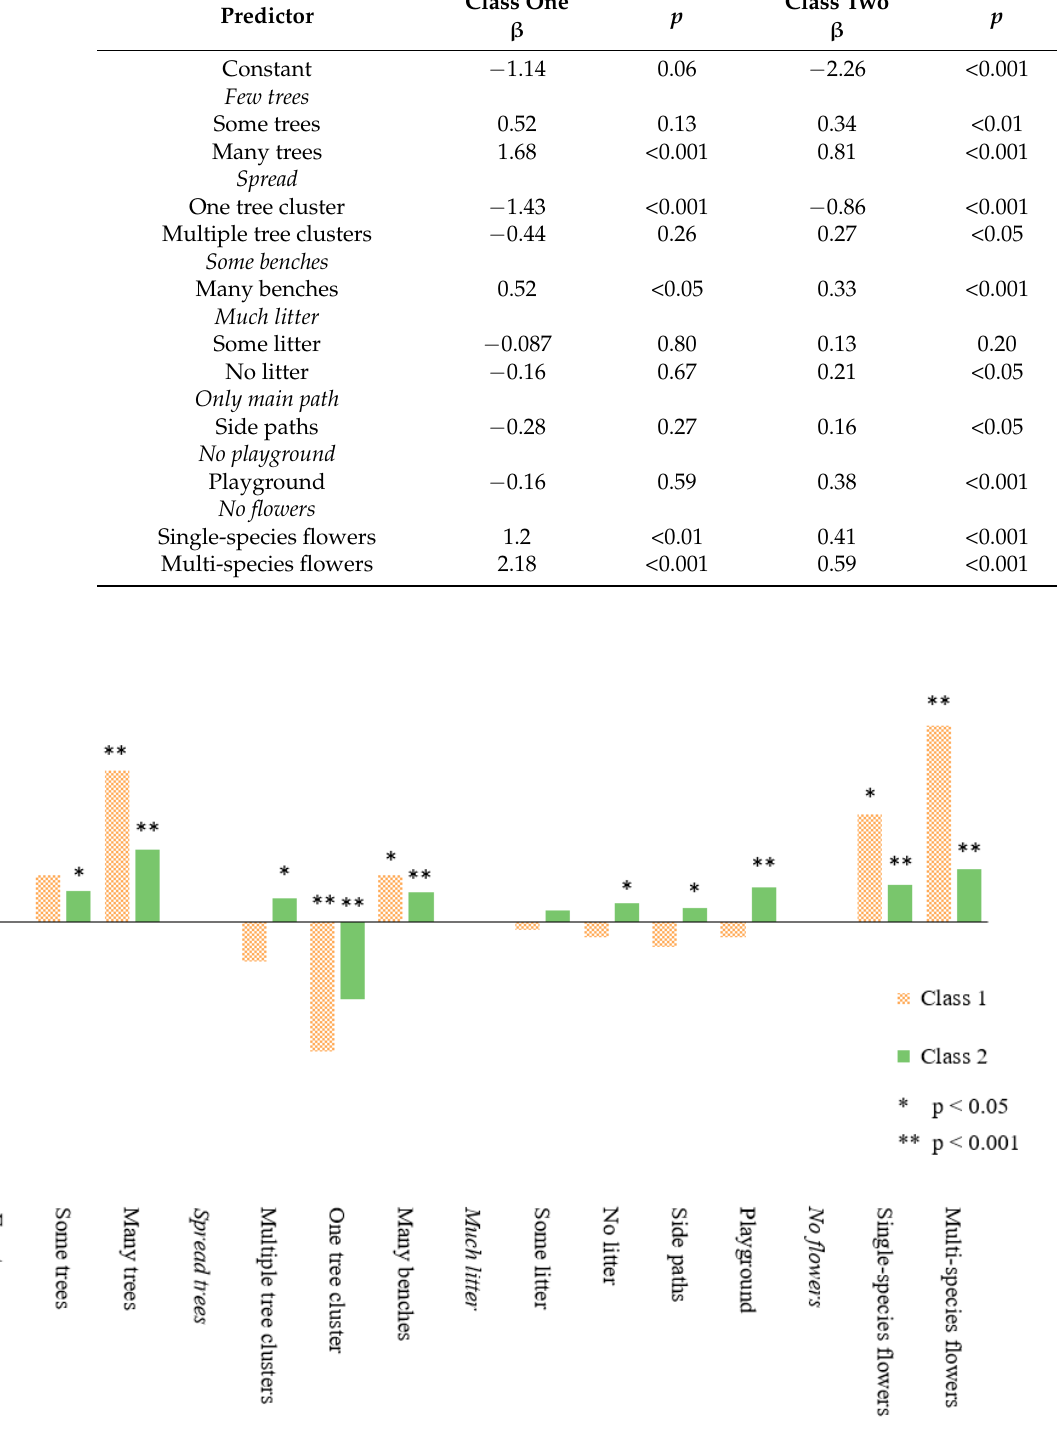
Figure 5. Diagram of the results of the LC model, which shows the influence of the elements on preferences for class 1 and class 2. Class 1 is indicated by dotted orange bars, while class 2 is indicated by solid green bars.